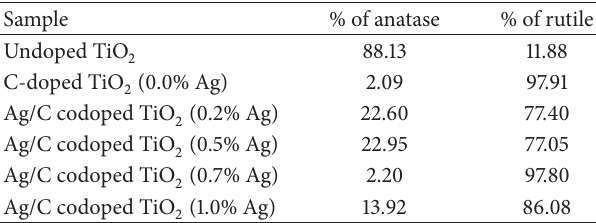
Table 1: Calculated percentages of anatase and rutile phases.